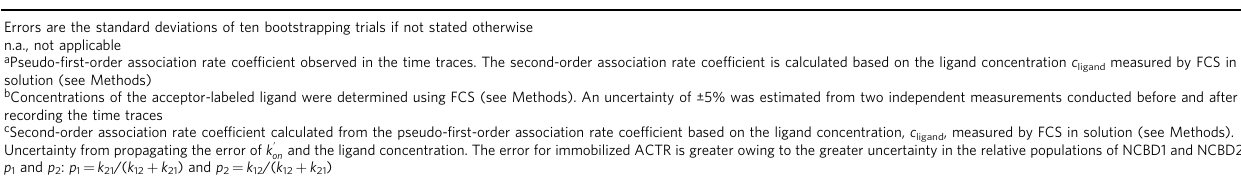
Table 1 Kinetic parameters determined with maximum likelihood analysis of single-molecule FRET experiments Immobilized protein